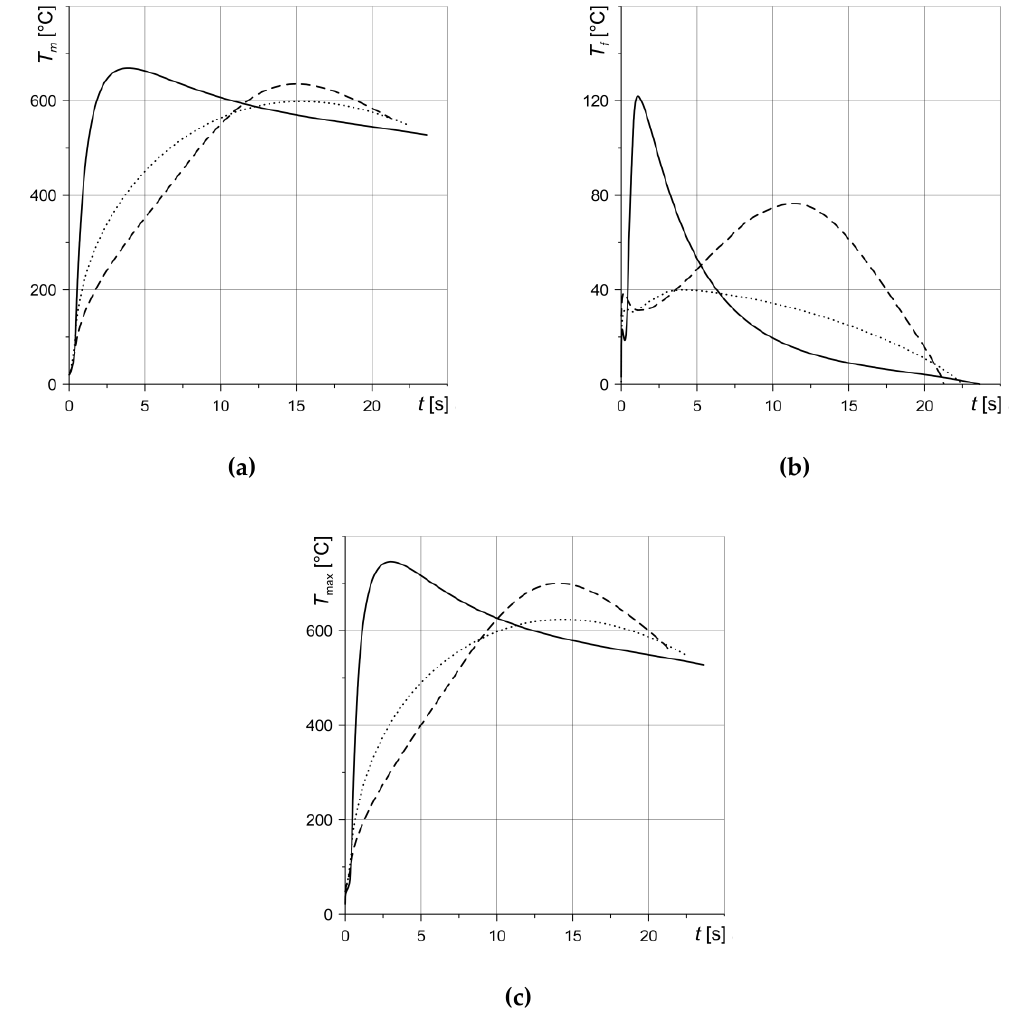
Figure 6. Evolution of the temperature during braking: ( a ) mean T m ; ( b ) flash T f ; ( c ) maximum T max . Solid line—variant 1, dashed line—variant 2, dotted line—variant 3.